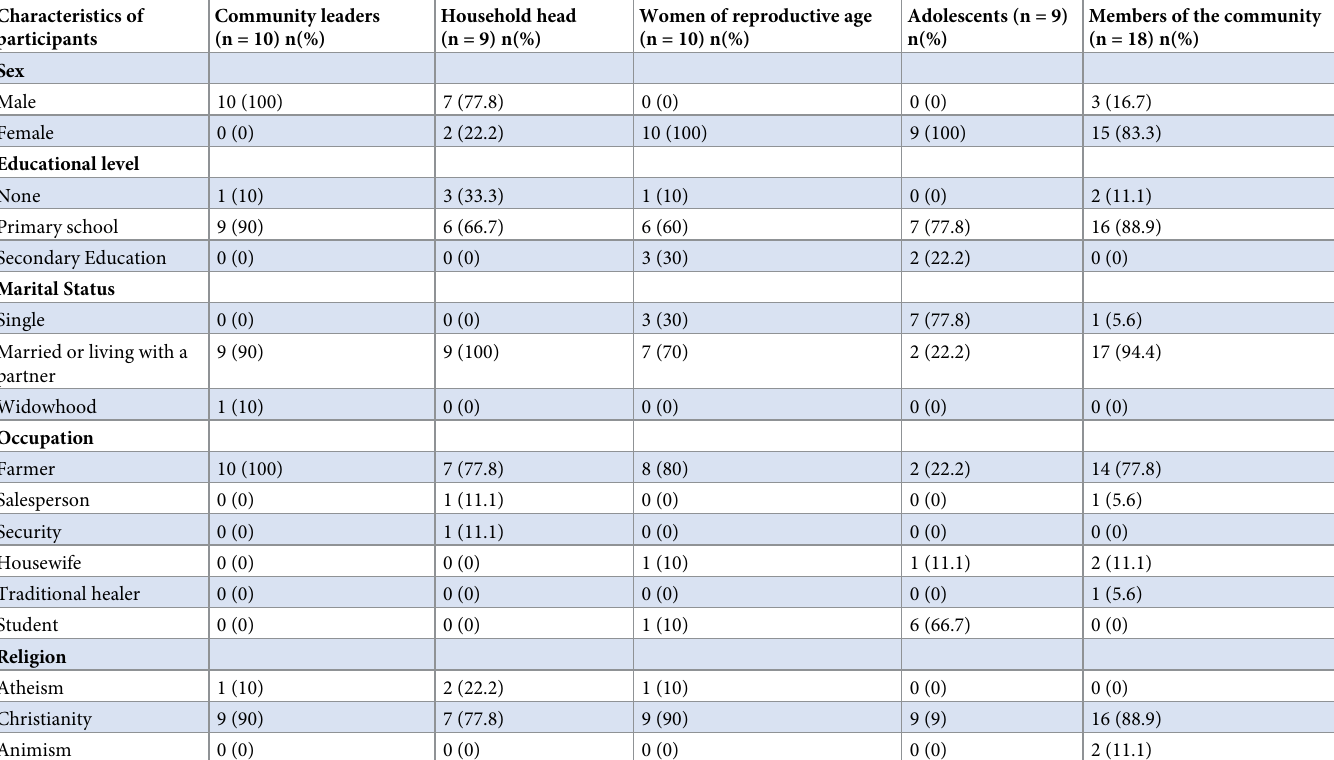
Table 2. Sociodemographic characteristics of participants per community group. Characteristics of